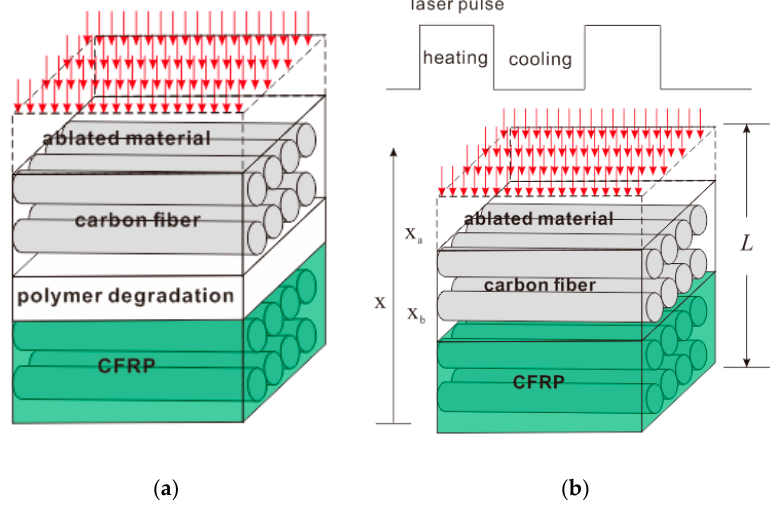
Figure 2. ( a ) Finite ‐ rate pyrolysis model; ( b ) Instantaneous pyrolysis model.